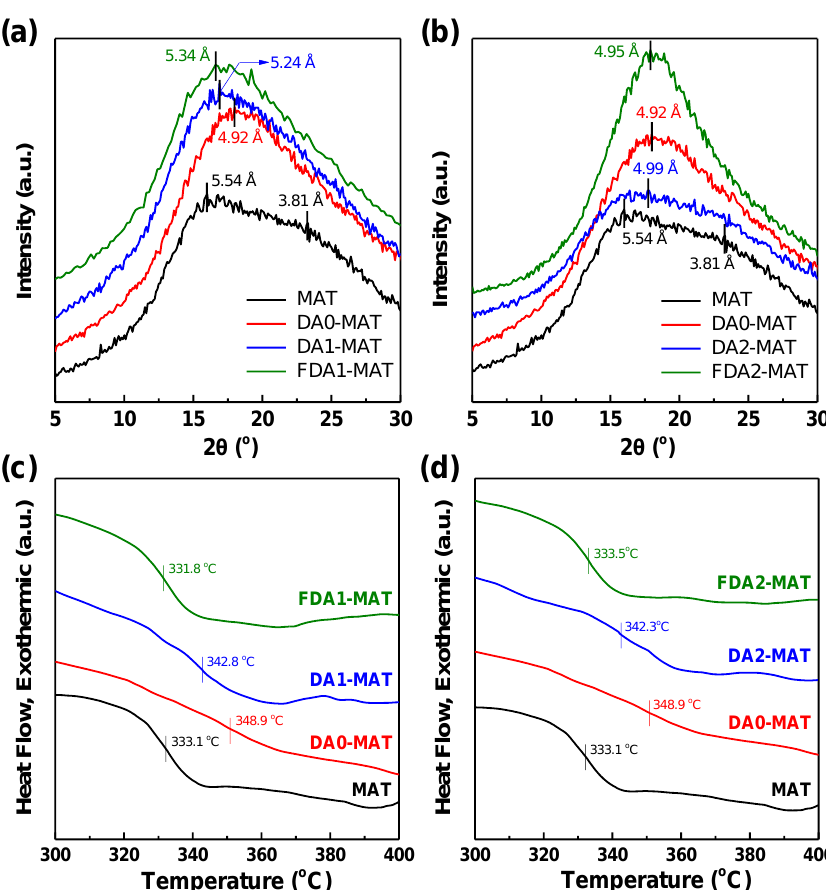
Figure 7. ( a,b ) XRD patterns and ( c , d ) DSC curves of diamine-modified Matrimid membranes.